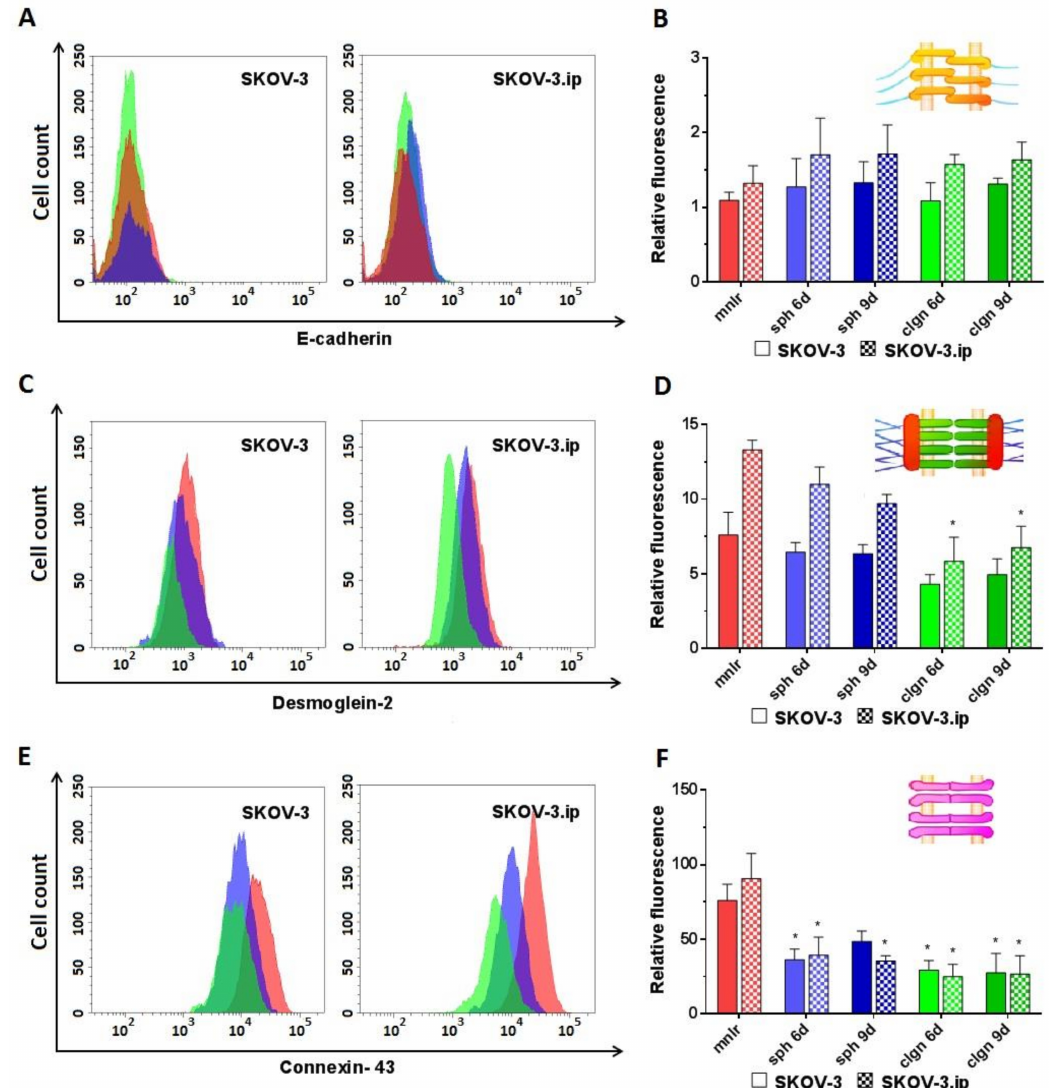
Figure 3. Expression level of analyzed proteins of adherens junctions (E-cadherin), desmosomes (desmoglein-2) and gap junctions (connexin-43) in SKOV-3 and SKOV-3.ip cells cultured in monolayer and 3D in vitro models. ( A , C , E ) The distributions of SKOV-3 cells (left plot) and SKOV-3.ip cells (right plot) according to fluorescence intensity detected after staining with E-cadherin-specific, desmoglein-2-specific and connexin-43-specific antibodies (red—monolayer culture, blue—spheroids, green—collagen hydrogel); ( B , D , F ) Levels of E-cadherin, desmoglein-2 and connexin-43 in monolayer and 3D models denoted as relative fluorescence values, calculated as a ratio of mean fluorescence intensity of cells stained with specific antibodies to mean fluorescence intensity of cells stained with antibodies of isotypic control. mnlr , monolayer; sph , spheroids; clgn , collagen hydrogel. “*” indicates significant di ff erence in RF level from monolayer culture (ANOVA, Holm–Sidak’s multiple comparisons test, p <